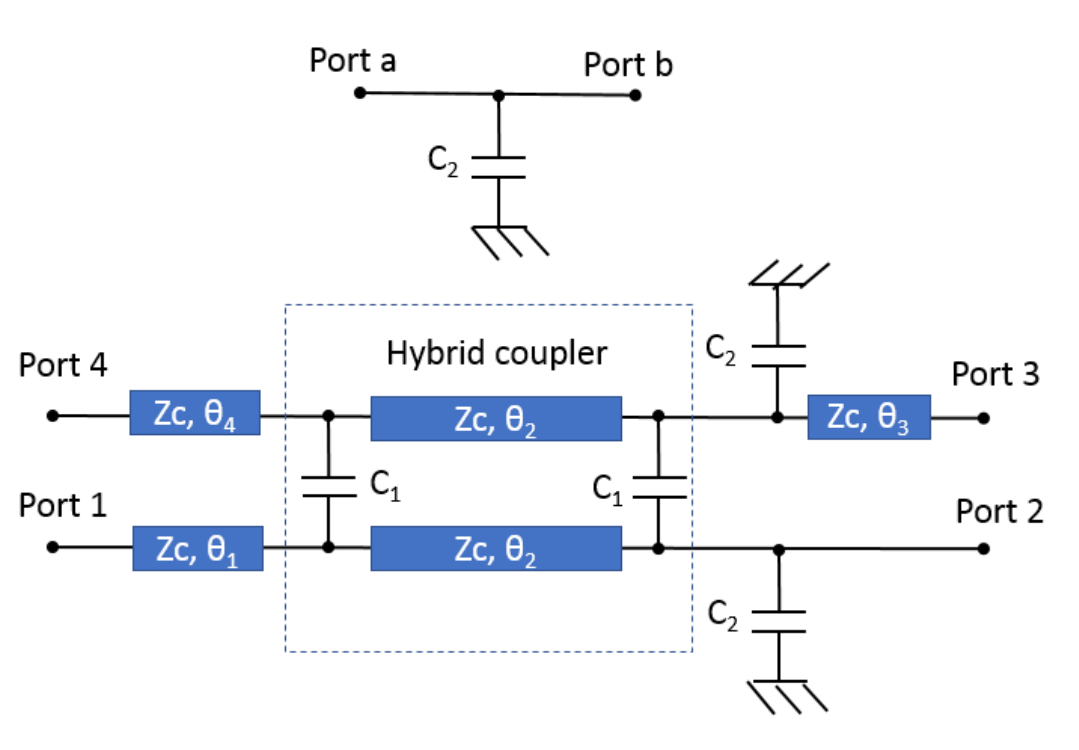
Figure 3. Feeding circuit